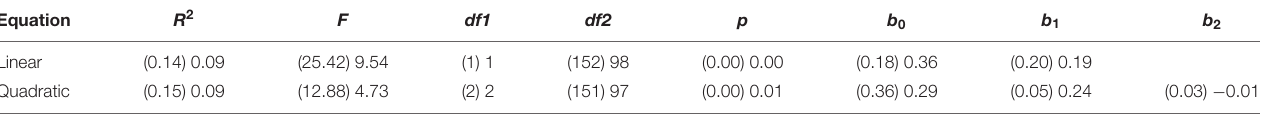
The values presented on the right side of the brackets refer to the females; the values presented within brackets refers to the males.